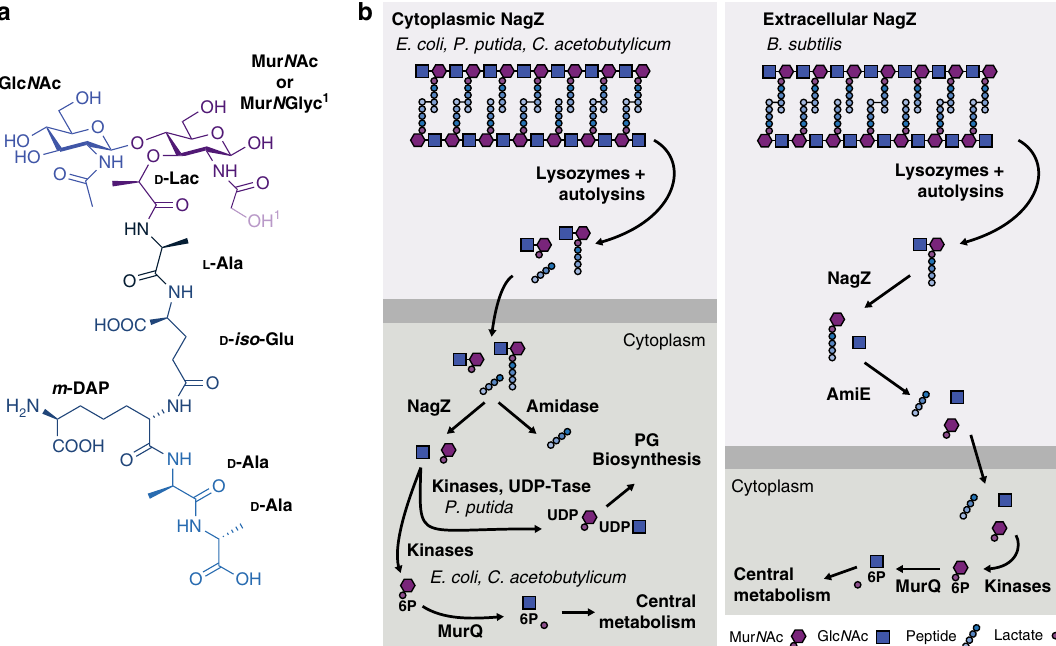
Fig. 1 Overview of PG recycling. a The basic building block of PG is Glc N Ac-Mur N Ac-pentapeptide. Enzymes produced by the bacterium or the host are able to cleave every major linkage in PG. b Known PG-recycling machinery is variable with respect to the localisation of NagZ and the subsequent conversion to Glc N Ac-1P or UDP-Glc N Ac/Mur N Ac. All known Mur N Ac recovery systems that sustain bacterial growth (as opposed to strictly recycling e.g. P. putida ) terminate at MurQ in the